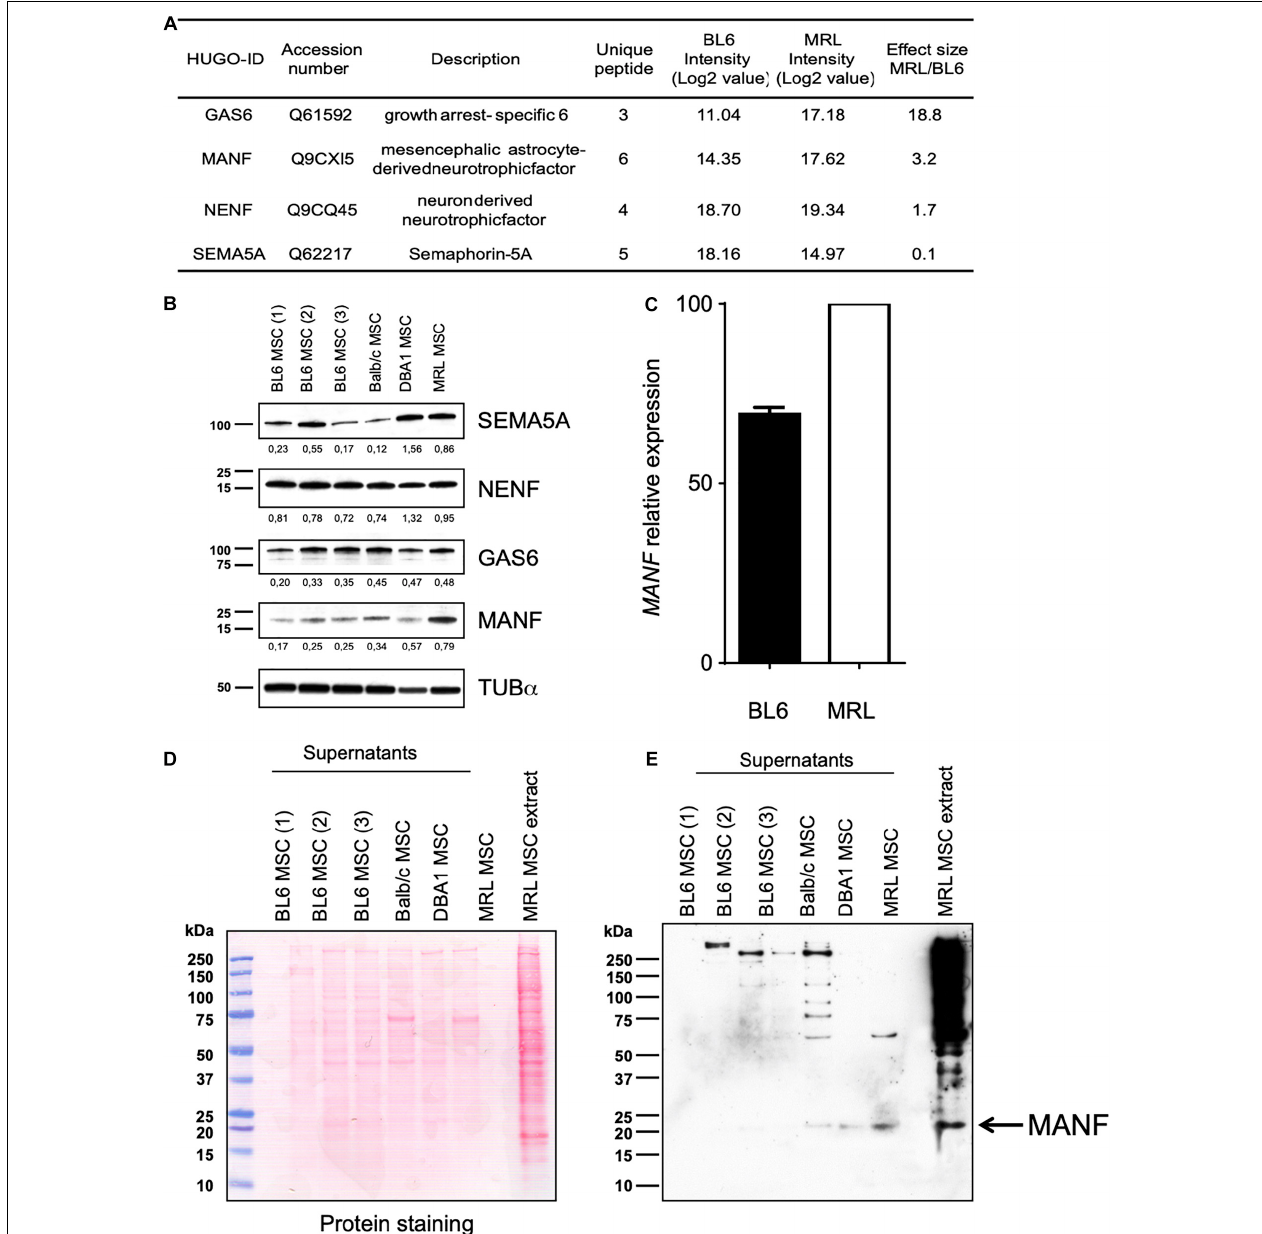
FIGURE 4 | MRL MSC produced and released higher amount of MANF than BL6, BALB/c and DBA1 MSC. (A) Proteomic analysis of differential expression of MANF, GAS6, NENF, and SEMA5A in MRL MSC compared to BL6 MSC secretomes. Effect size indicate the standardized mean difference in protein expression level between MRL MSC and BL6 MSC. For each protein, the median intensity levels (Log 2 value) in MRL MSC and BL6 MSC are indicated. Normalized protein intensities were used to calculate the Effect size MRL/BL6. (B) Western blot analysis of MANF, GAS6, NENF, and SEMA5A in whole-cell extracts from BL6, BALB/c and DBA1 MSC. The intensity value of each target protein band was normalized against the intensity value of α -Tubulin gel band used as the internal loading control for each sample. (C) MANF mRNA expression level in MRL MSC and BL6 MSC. Western blot analysis of supernatants of BL6, BALB/c, and DBA1 MSC showing blotted proteins stained with Ponceau S (D) and the MANF protein band revealed by the anti-MANF antibody (E) . MRL MSC whole cell extract was used as a positive